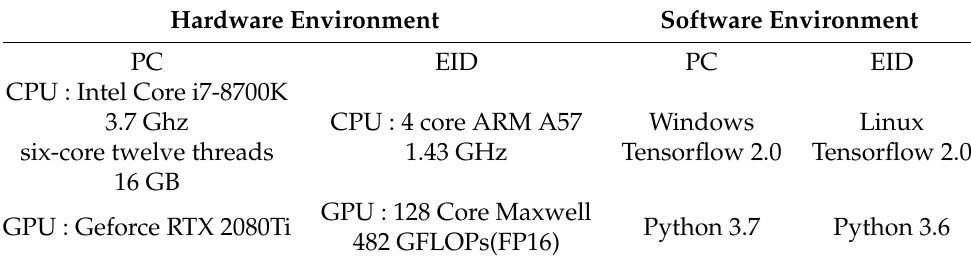
Table 2. Hardware and software experimental environment